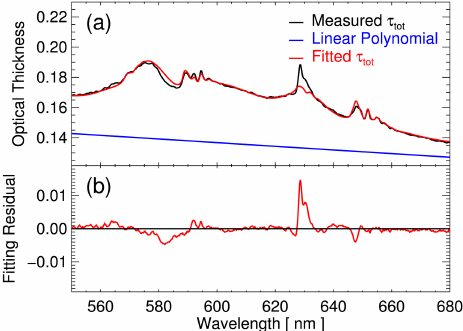
Figure B2. Similar to Fig. B1 but for H 2 O. (a) Spectral fitting result of the SMART–s H 2 O algorithm at 16:55UTC on 14 October 2019 measured at the same location as in Fig. B1. Panel (b) presents the fitting residual (measured optical thickness subtracted by model op- tical